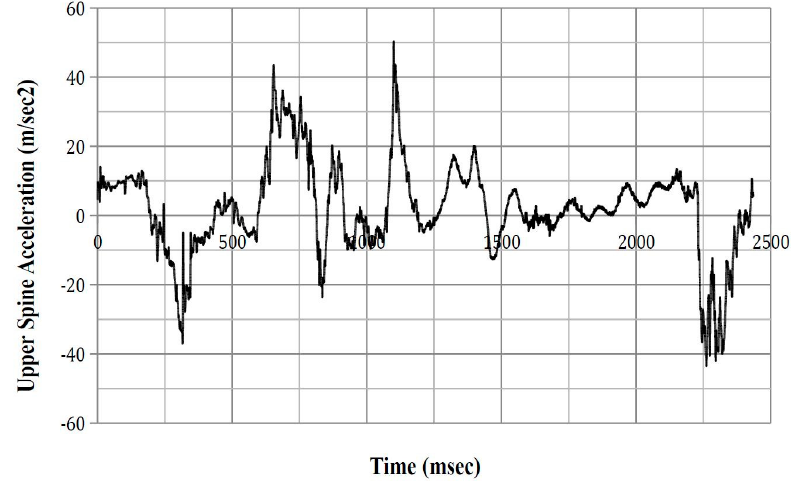
Figure A10. ATD Position 1 upper spine acceleration.